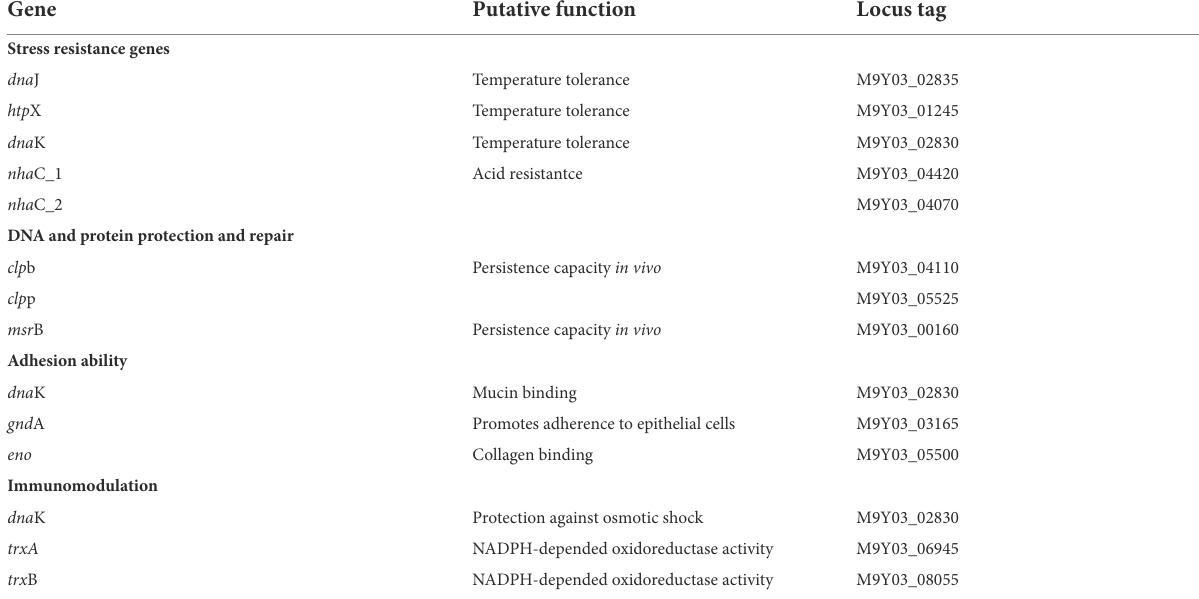
TABLE 1 Probiotic-related genes present in L. salivarius